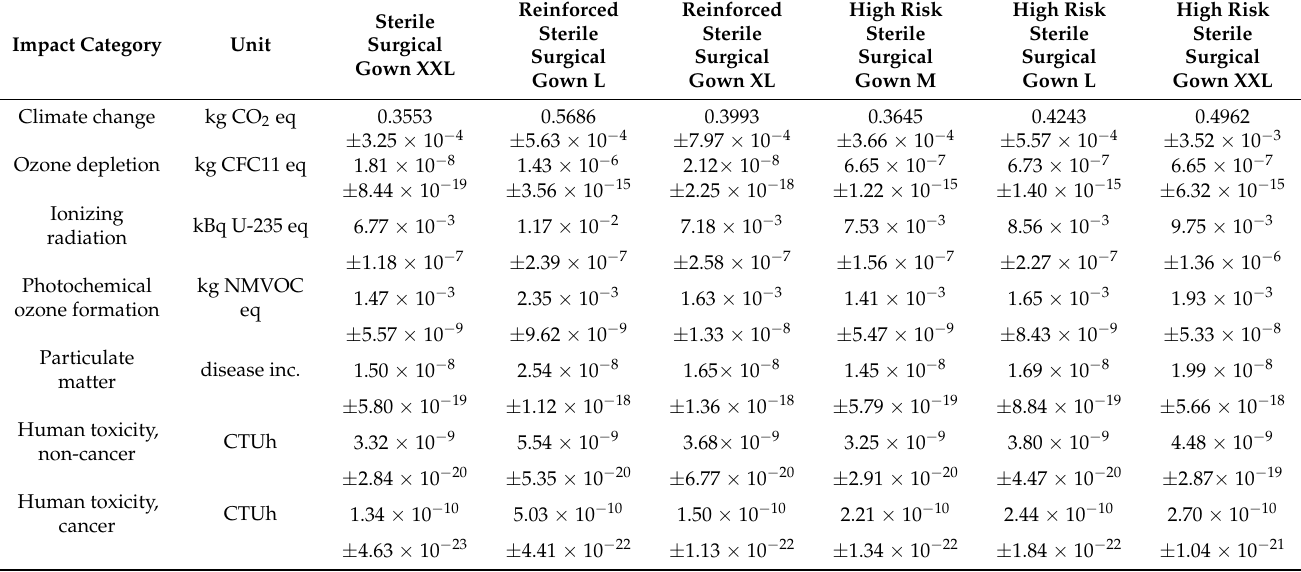
Table 4. Environmental Footprint characterization of the single-use nonwoven (Part